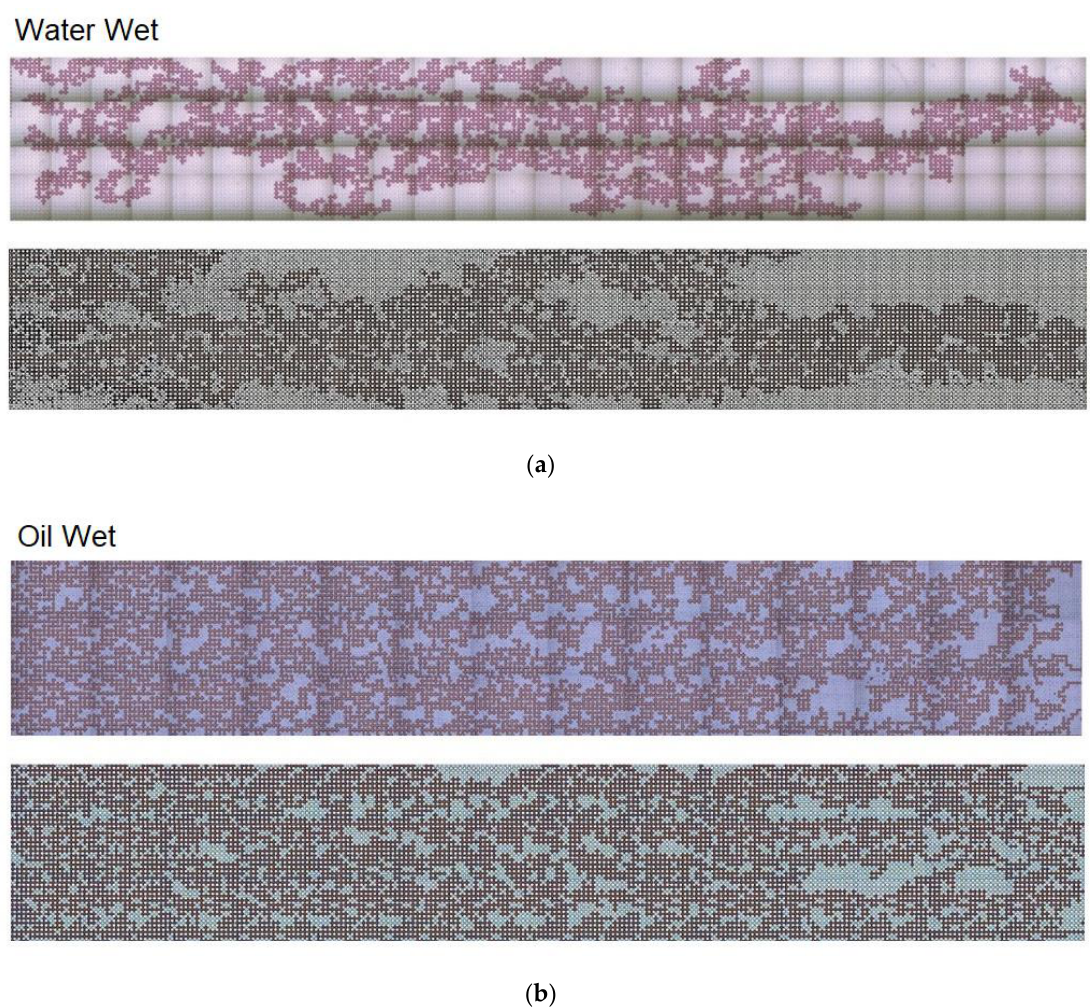
Figure 5. Water invasion pattern in two runs at the same flow conditions for the ( a ) hydrophilic (WW) porous media microfluidic device (Ca = 3.5 × 10 − 7 ) and ( b ) hydrophobic (OW) device (Ca = 6 × 10 − 6 ).